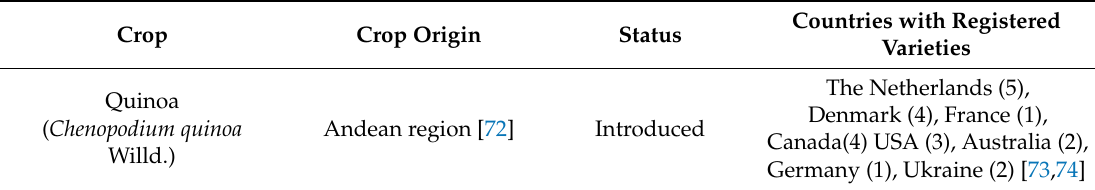
Table 2. Neglected and underutilized species successfully introduced to several countries as alternative crops for drought